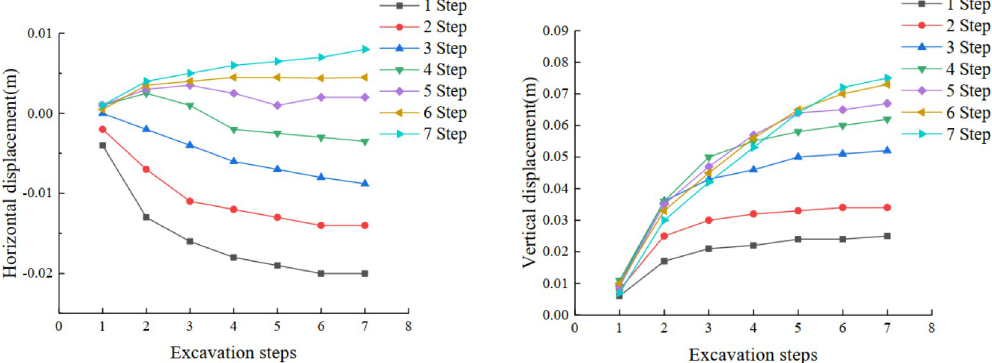
Fig 11. (a). Displacement curves of each step during excavation (horizontal displacement). (b). Displacement curves of each step during excavation (vertical